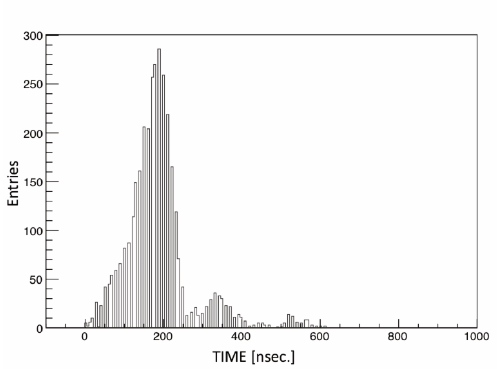
Figure 7. Time di ff erence between pulse generator for light source and RTK-GPS measurment for ranging.